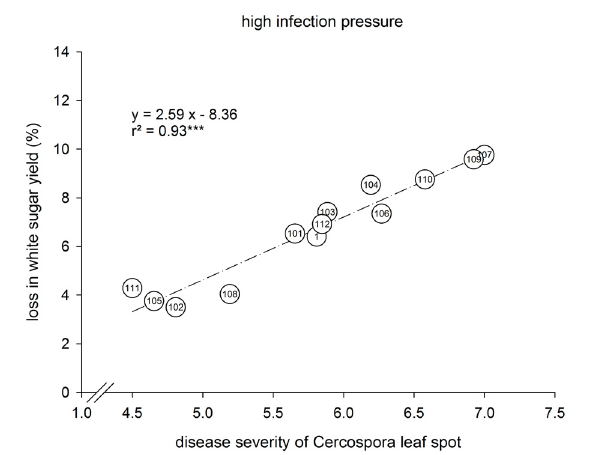
FIGURE 4 | Disease severity of Cercospora leaf spot (CLS) and relative loss of white sugar yield (WSY) in 13 sugar beet varieties tested at 13 environments with high infection with CLS; Germany, 2009–2011. Relative loss in WSY is the yield difference between healthy and non-treated fungicide levels as percentage of WSY in the healthy level. DS was rated in the non-treated plots on a 1–9 scale (1: no infection, 9: very high infection; BSA, 2000). ∗∗∗ P ≤ 0.05 and